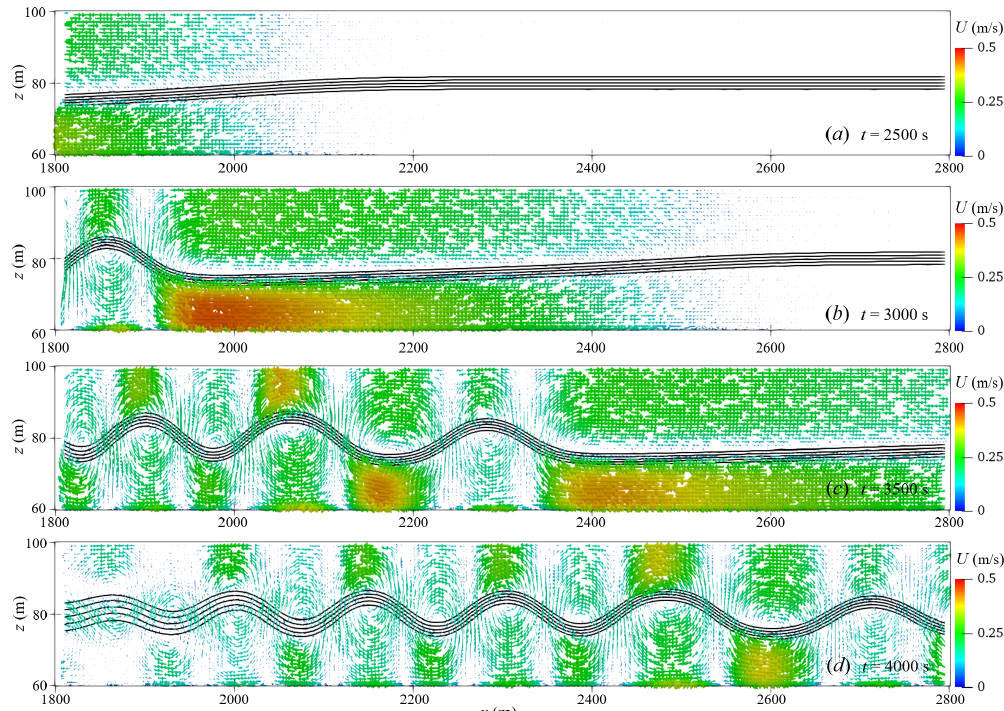
Figure 24. Velocity vector field of wave train in shallow water areas.